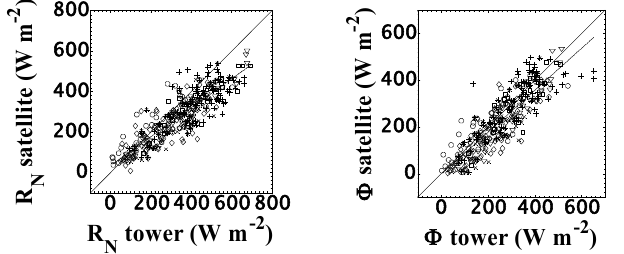
Figure 7. Comparison of satellite and tower monthly average 13:30LT (a) R N and (b) (cid:56) [ (cid:56) = (H + λE ) (for the tower sites)]. For details of the site characteristics see Table 1. For the compara- tive statistics see Table 3. The solid line is the pooled linear regres- sion given in Table 3. ( + EBF; × MF; ◦ GRA; * CRO; ∇ ENF; (cid:5) DBF; (cid:3)